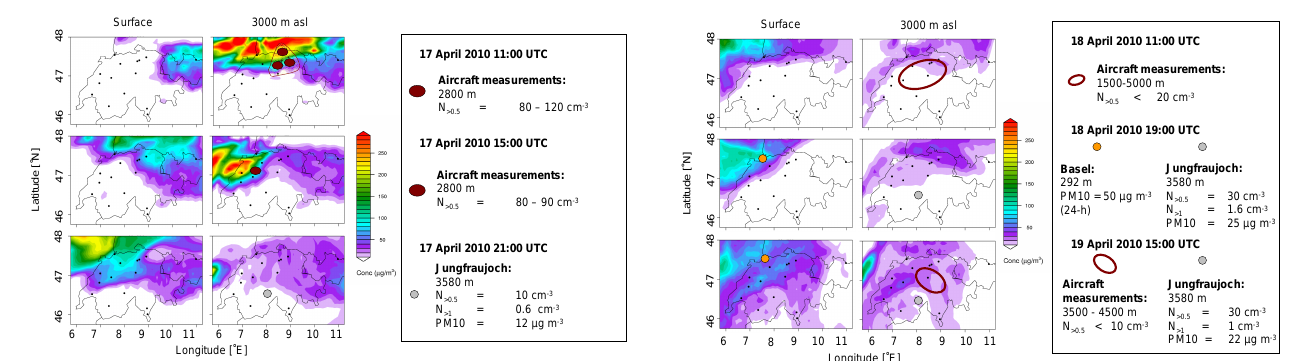
Fig. 15. 18/19 April 2010: comparison of the simulated vol- canic ash concentration (surface and 3000ma . s . l . ) with the number and/or mass concentration values retrieved from the in-situ mea- surements.